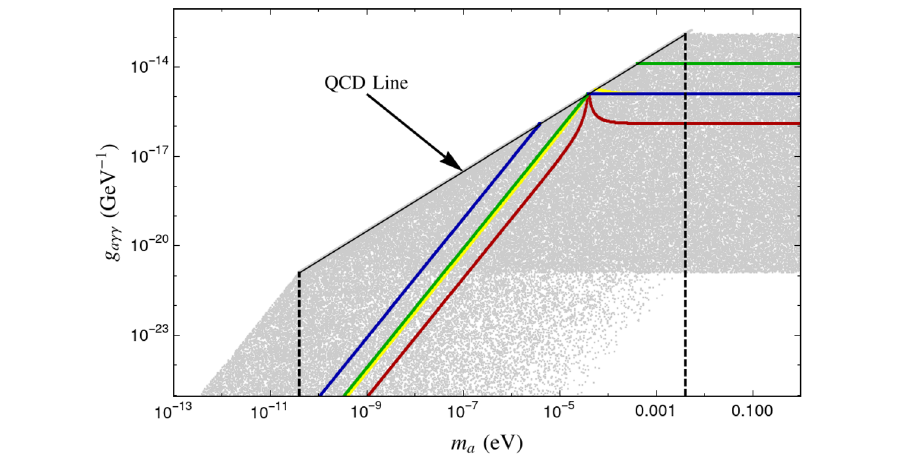
Figure 1 . Scatter plot showing the mass and photon coupling of the two mass eigenstates in the model described by the potential (4.2). Shown in light grey are the points generated, the dashed lines show the maximum and minimum masses for the QCD-like eigenstate and are set by the chosen range of f . The thin black line shows the QCD axion line. The coloured lines show the points 1 , f 2 generated for fixed decay constants: the red line shows the case where f the yellow line shows f = f = 10 12 GeV , the green line shows f 1 2 the blue shows f = 10 13 GeV , f = 10 12 GeV 1 2